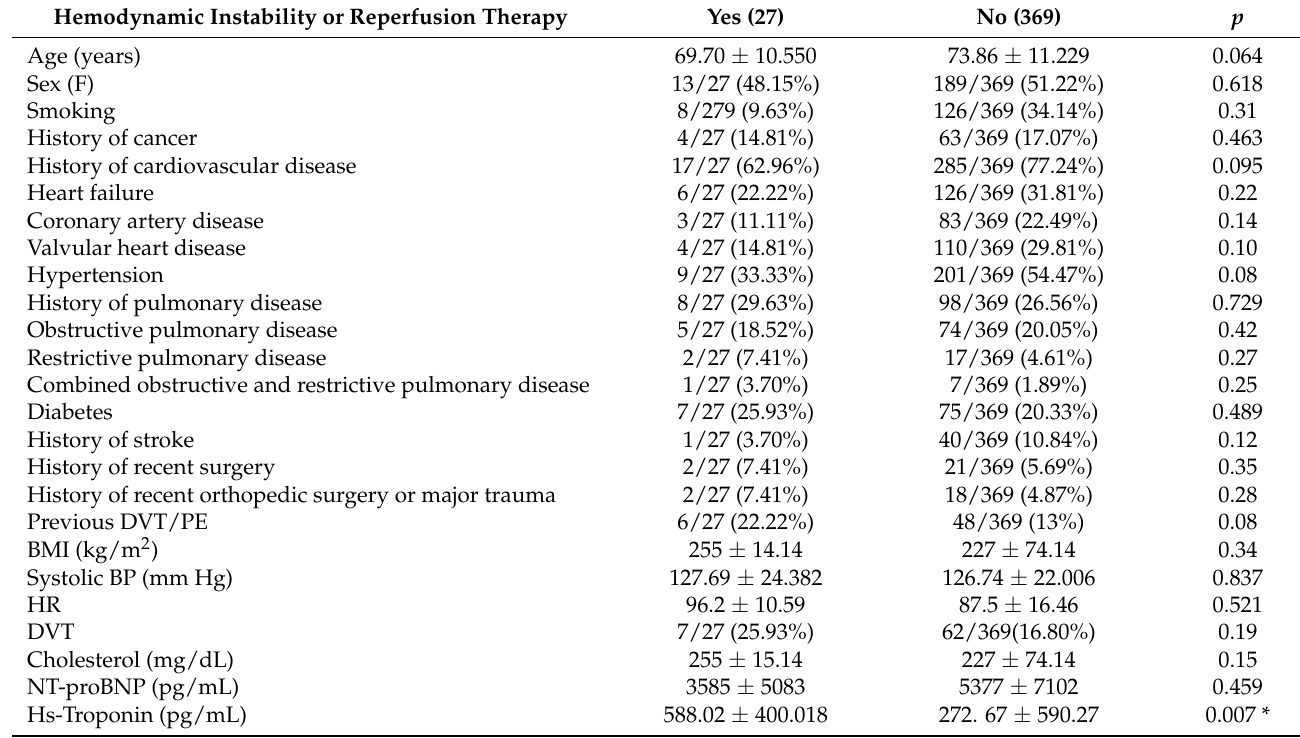
Table 5. Comparative baseline demographic, clinical and laboratory parameters in patients with and without in hospital hemodynamic instability or need of reperfusion